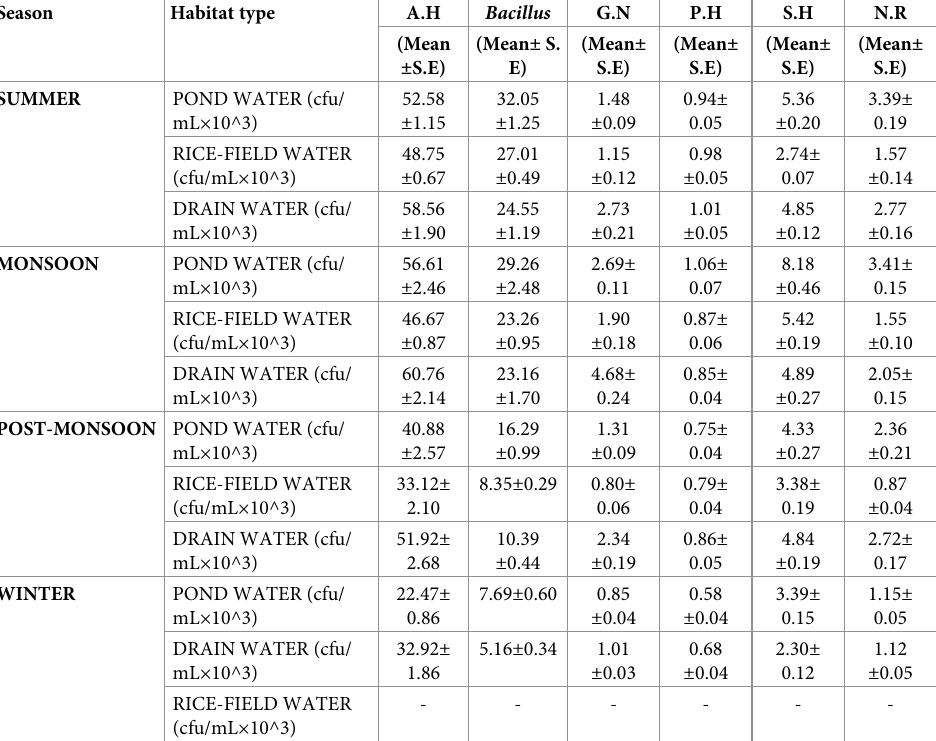
Out of which eight bacterial isolates (HABW1, HABW3, HABW4, HABW6, HABW10, HABW12, HABW14 and HABW15) were screened from all the breeding habitat water irre- spective of habitat type in the presence of anopheline larvae throughout the year. Colony mor- phologies of these bacterial isolates have been provided in Table 5. Table 4. Season wise different groups of bacterial populations in the form of colony forming unit (cfu) in the breeding habitats of Anopheles subpictus mosquitoes.